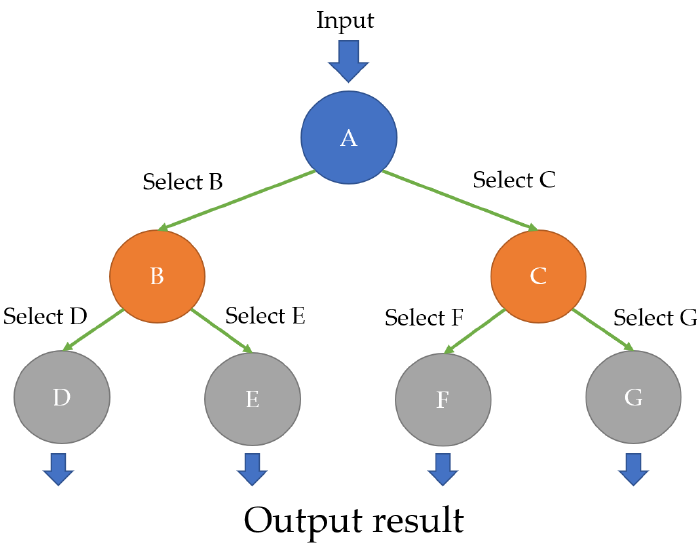
Figure 2. An example of model ‐ switching architecture.